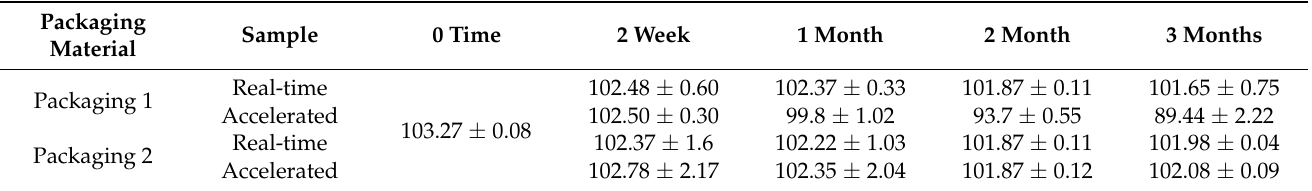
Table 4. The paracetamol content for samples stored in packaging 1 and packaging 2 at different time points (0, 2 weeks, 1, 2, and 3